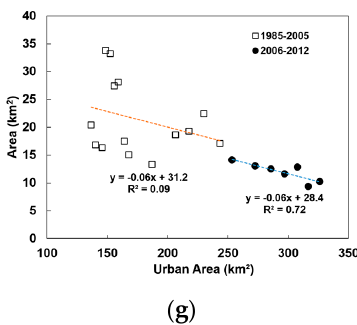
Figure A5. Scatterplots of Cetian reservoir water extents against ( a ) precipitation, ( b ) GDP, ( c ) population, ( d ) electricity energy production, ( e ) raw coal production, ( f ) value of agriculture output and ( g ) urban area during 1985–2005 and 2006–2012.